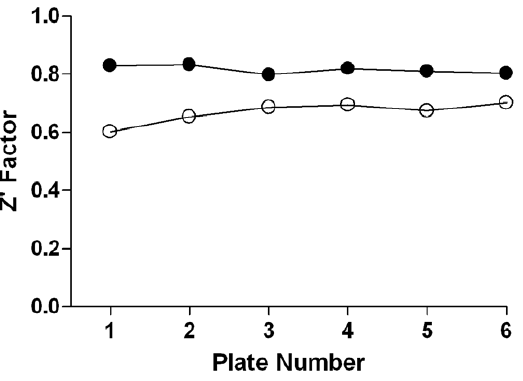
N ) and HSA (o) screen